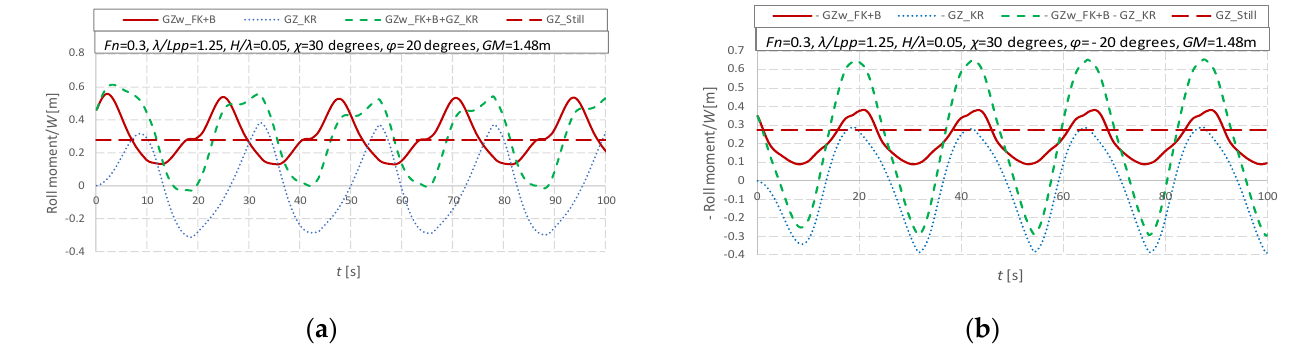
Figure 6. Comparison between the roll-restoring arms and the rudder forces in the rolling direction